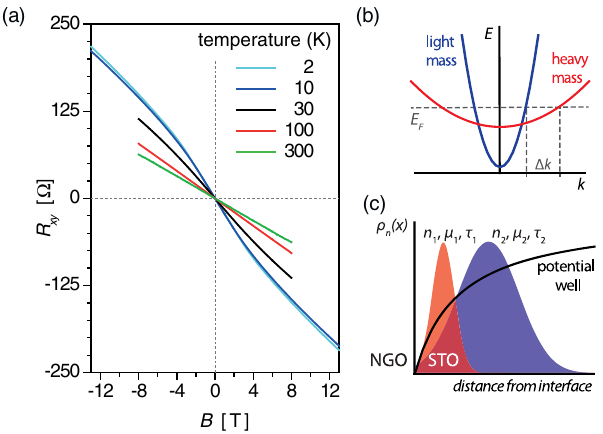
FIG. 2. (a) Antisymmetrized Hall resistance R xy ð B Þ obtained 1 × 10 − 4 mbar. for the NGO/STO heterostructure grown at p dep ¼ (b) In the band structure schematic (after Refs. [16,17]), electrons have distinct effective masses m (cid:4) i for light and heavy mass bands. (c) In the defect inhomogeneity scenario, electrons experience distinct scattering times τ i , as distributions are located at different distances from the